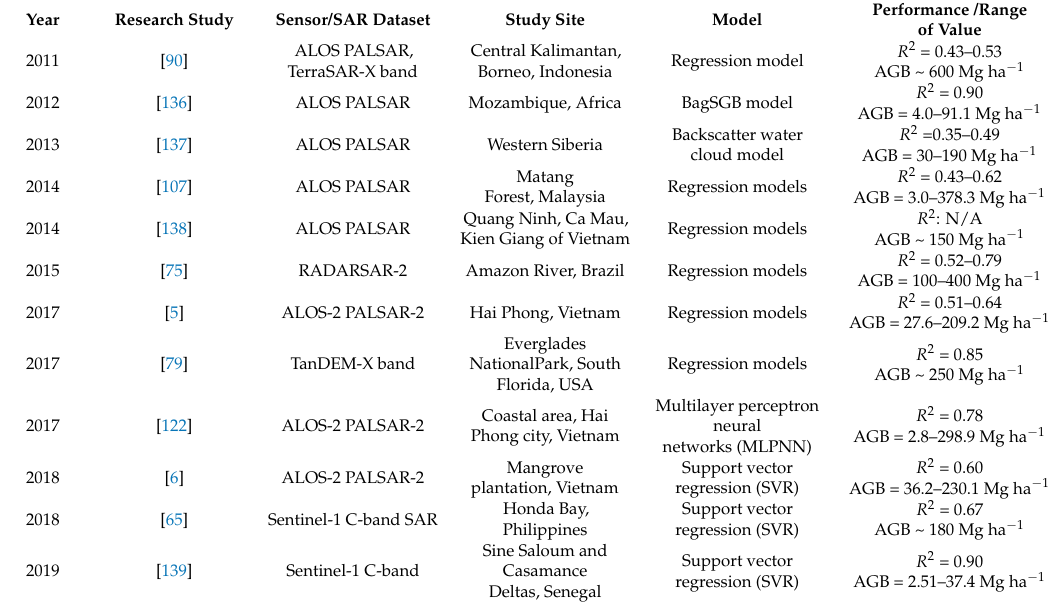
Table 4. Methods used for above-ground biomass (AGB) estimation using